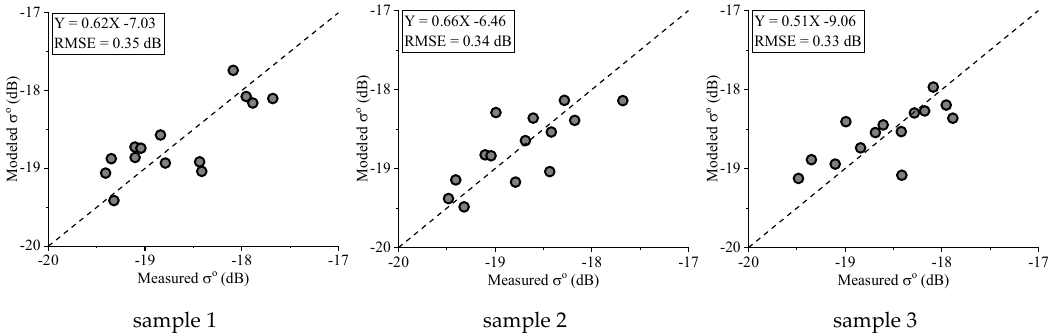
Figure 9. Scatterplots between modelled and measured VH backscatters.